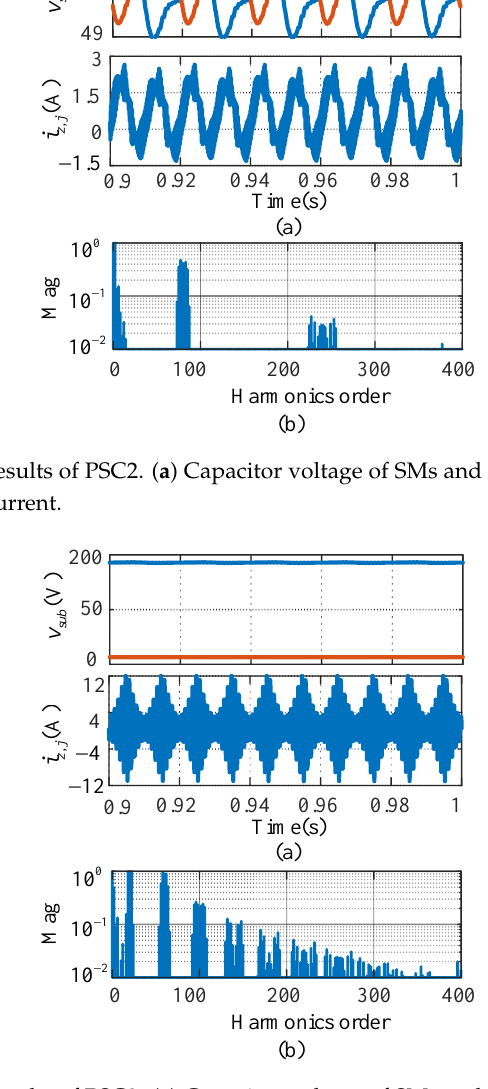
Figure 16. Simulation results of PSC3. ( a ) Capacitor voltage of SMs and circulating current. ( b ) FFT analysis of circulating